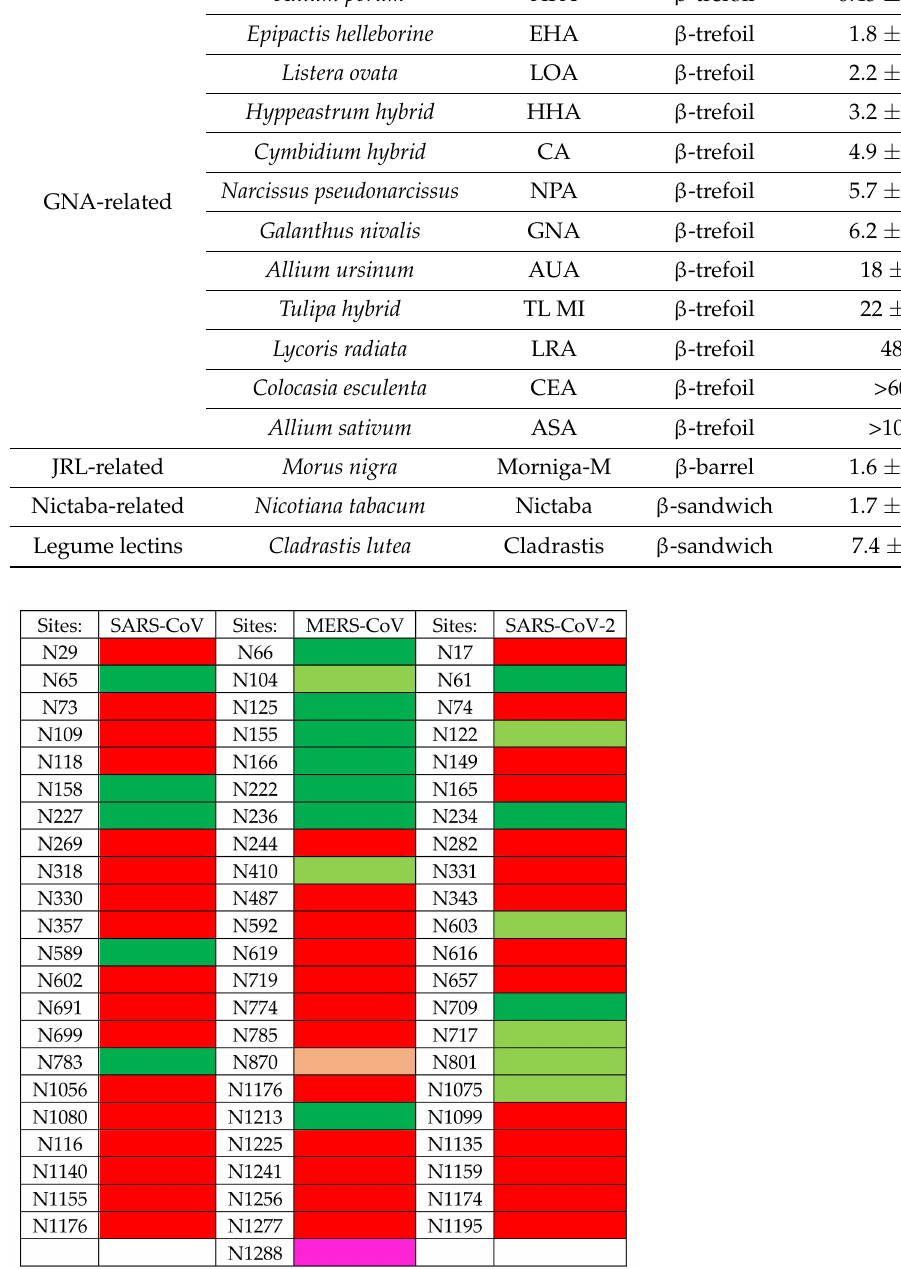
Figure 26. Site-specific N -linked glycosylation of SARS-CoV, MERS-CoV, and SARS-CoV-2. Sites containing (almost) exclusively complex glycans (colored red), high-mannose glycans (colored green), and hybrid glycans (colored magenta), are indicated. Sites harboring a mixture of complex glycans, high-mannose glycans, and a few hybrid glycans are colored pale green or pink, depending on the predominant high-mannose glycans (pale green) or complex glycans